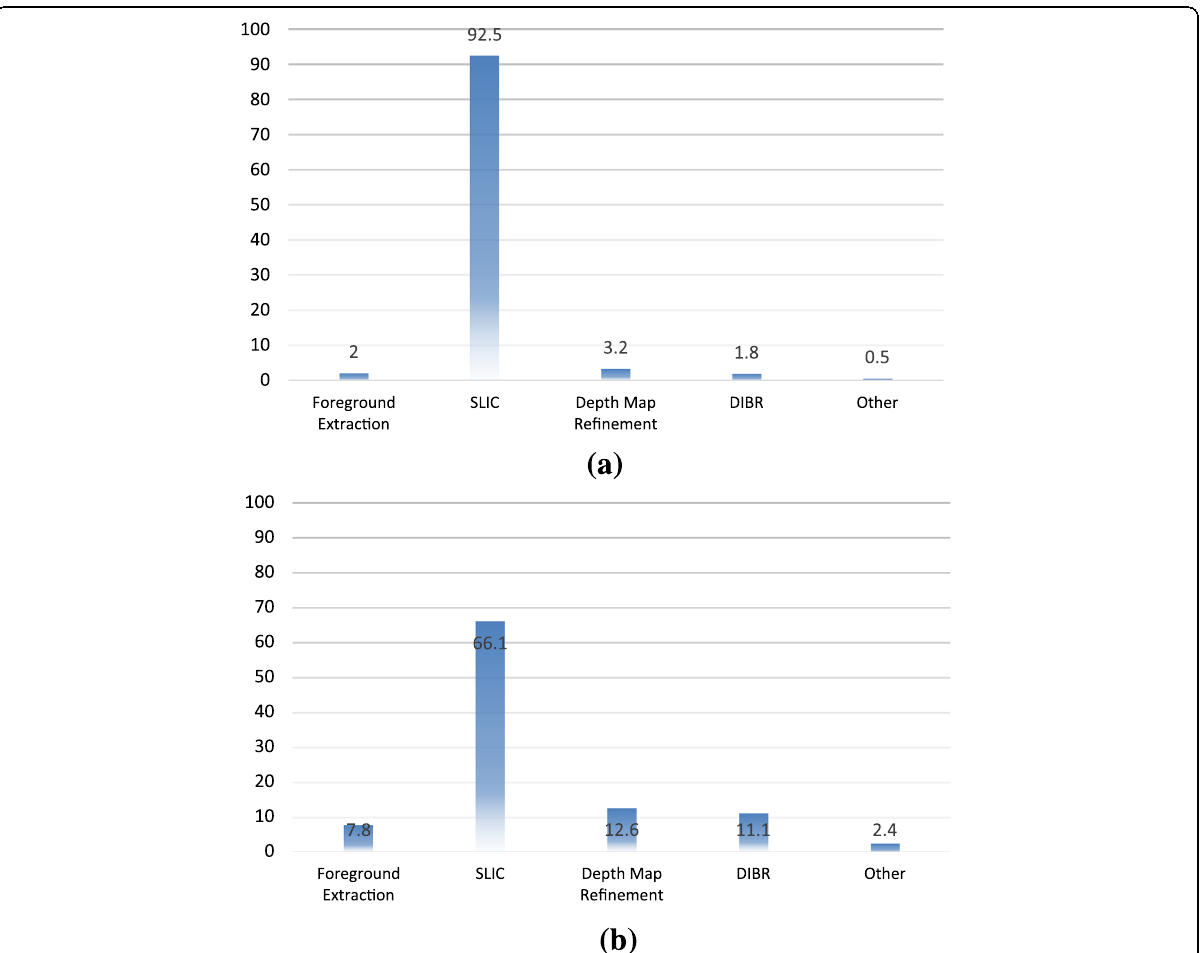
Fig. 12 Profiling on computation time for each procedure. a 1.040 s/frame on PC environment, and b 4.13 s/frame on